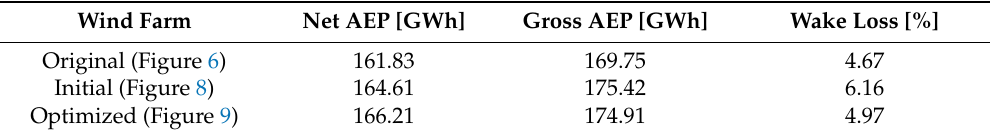
Table 3. AEP values comparison of the original, initial, and optimized wind farms.